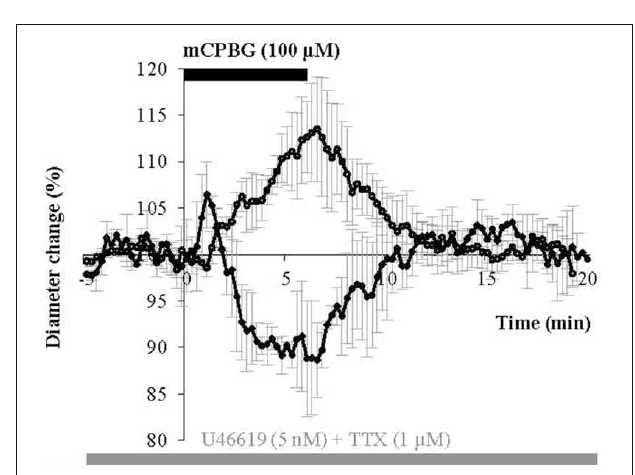
FIGURE 7 | mCPBG induces TTX-insensitive vasodilations and vasoconstrictions. Mean vascular dilation ( n = 5) and constriction ( n = 2) induced by mCPBG (100 μ M) in the presence of TTX (1 μ M) and U46619 (5nM).